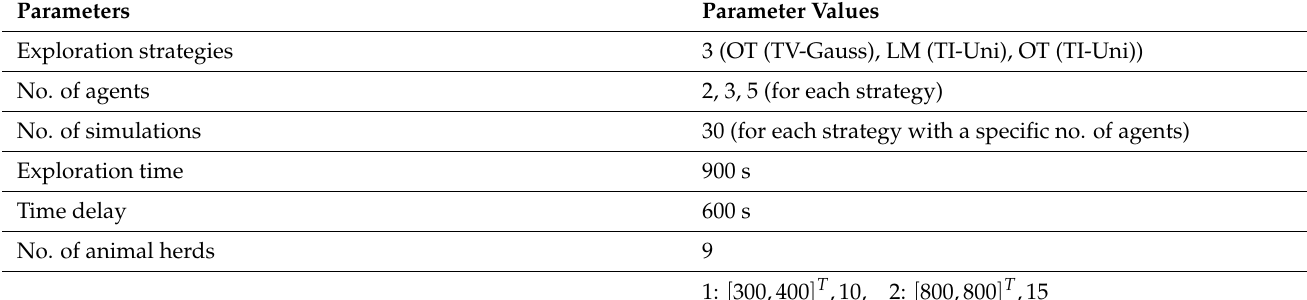
Table 1. Parameters for simulation performed for variation of number of